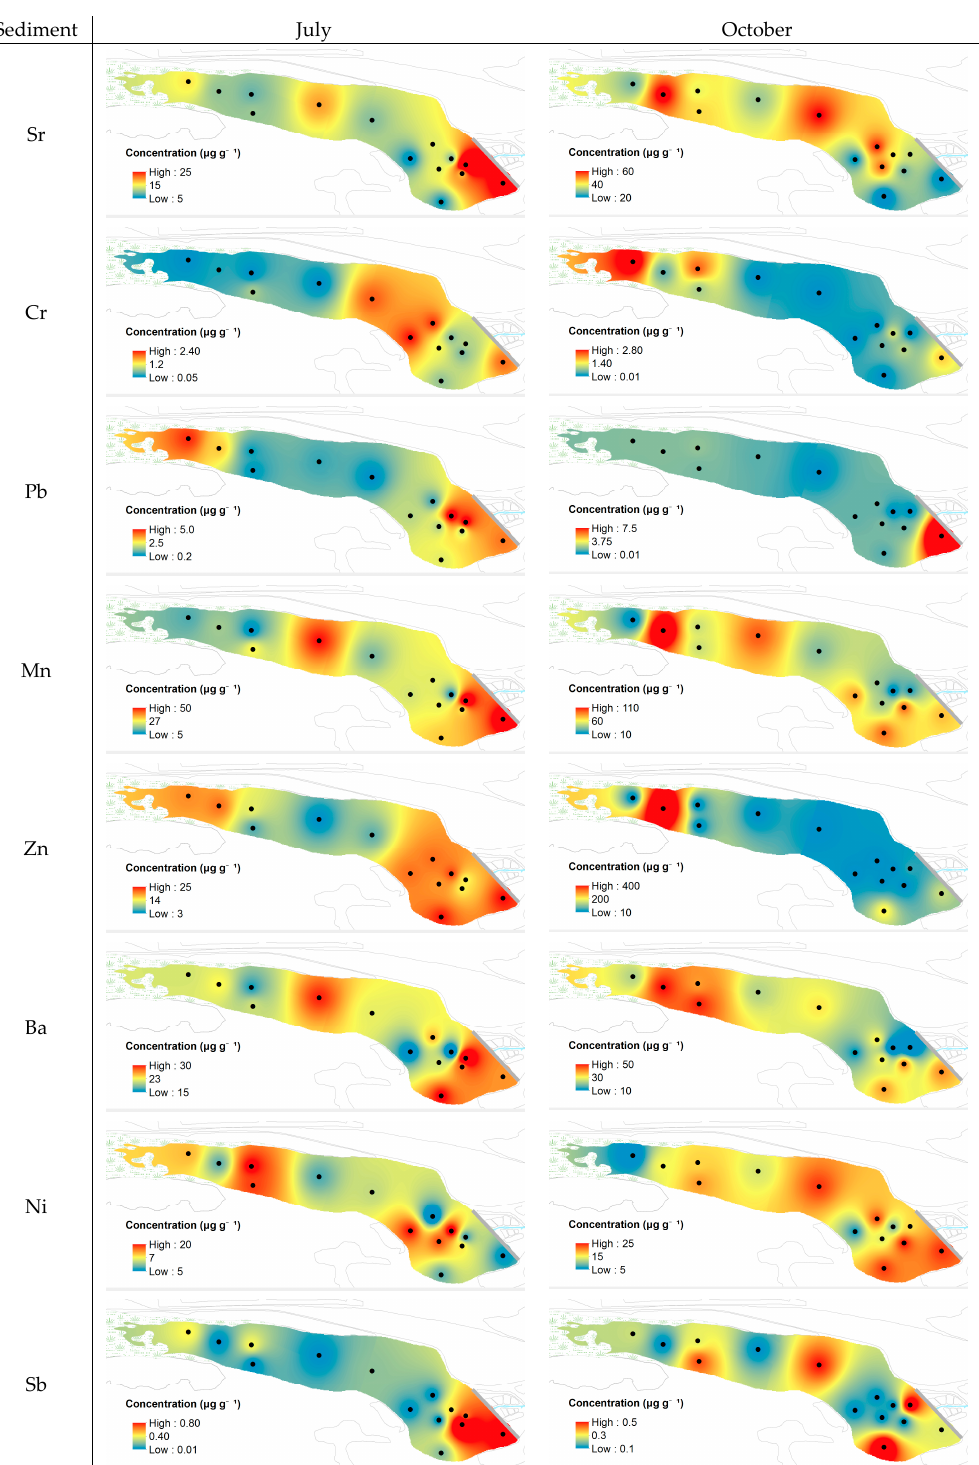
Figure 9. Spatial distribution of Sr, Cr, Pb, Mn, Zn, Ba, Ni, and Sb in sediment of Podu Iloaiei Dam Lake for July and October sampling sessions.